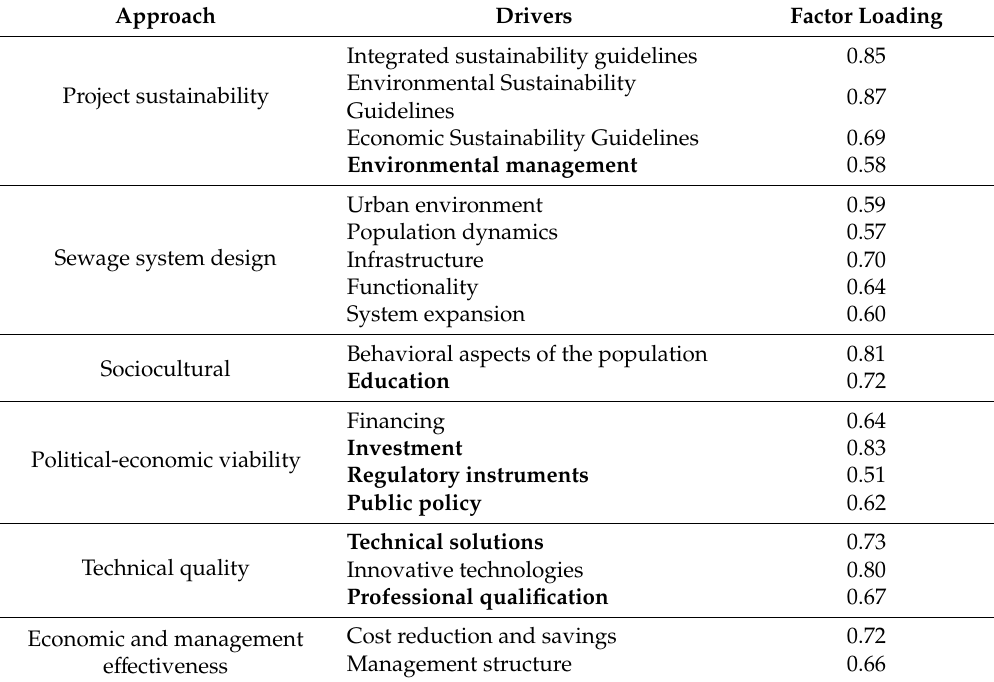
Table 3. Drivers grouped and named according to the aspect of the reality represented by each one.